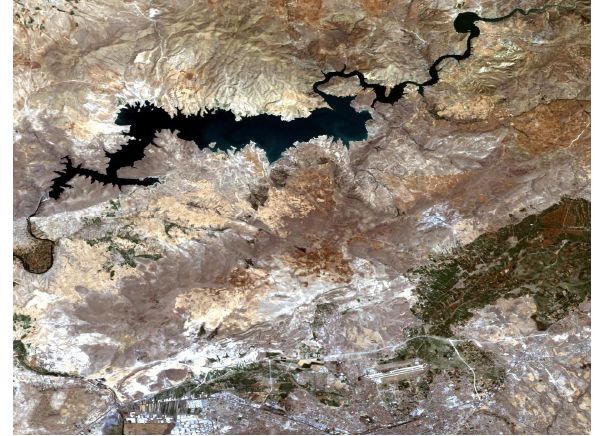
Image 1: Landsat 5 satellite image (2007)